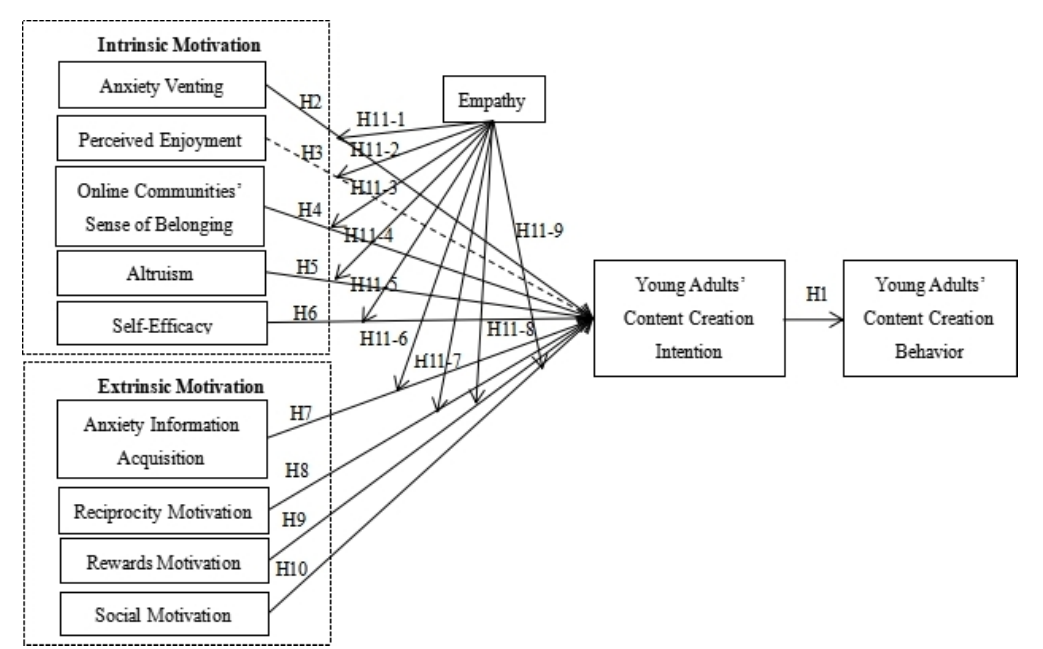
Figure 1. Research model.